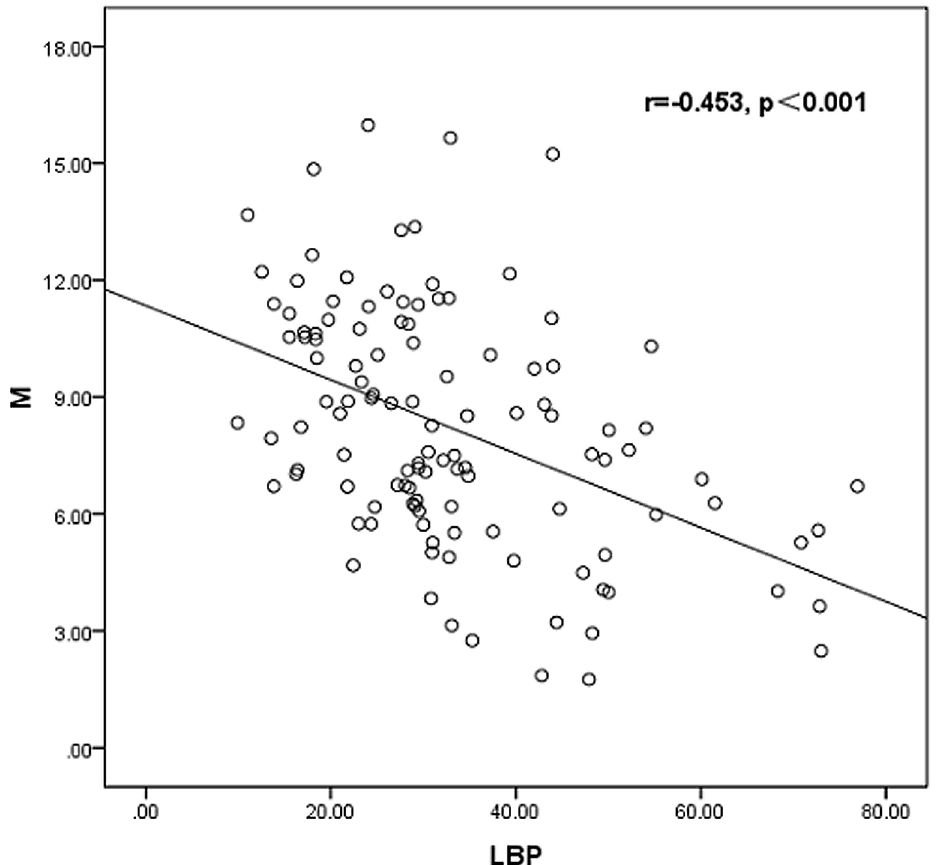
Fig 2. Linear correlations between LBP level and M